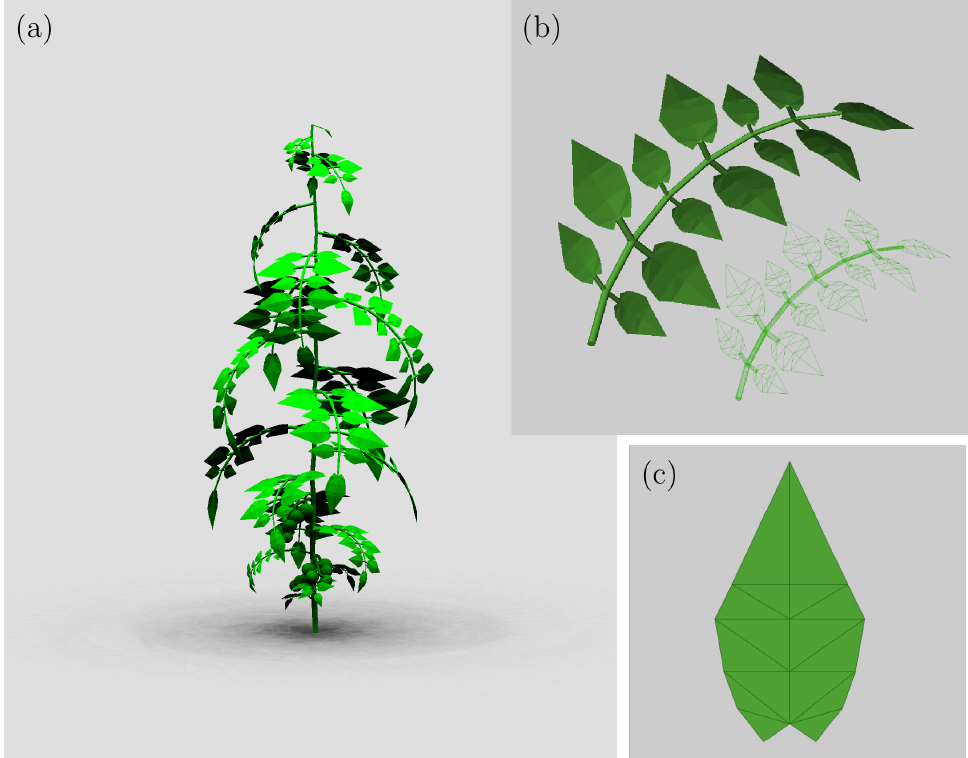
Figure 2. Screenshots of the 3D tomato plant model as described in Zhang et al. [35]. ( a ) a rendered image of the whole virtual plant (uniformly coloured), ( b ) a detail enlargement of leaf with rank 13 with the underlying wireframe triangulation, and ( c ) an image of a single leaflet with the overlay of the wireframe triangulation. A leaflet is modelled of eight vertical mirror symmetric arranged faces (triangles), making it in total 16 faces for one single leaflet. The whole plant consists roughly of 25.7 k vertices forming a triangulation of about 8.5 k faces.